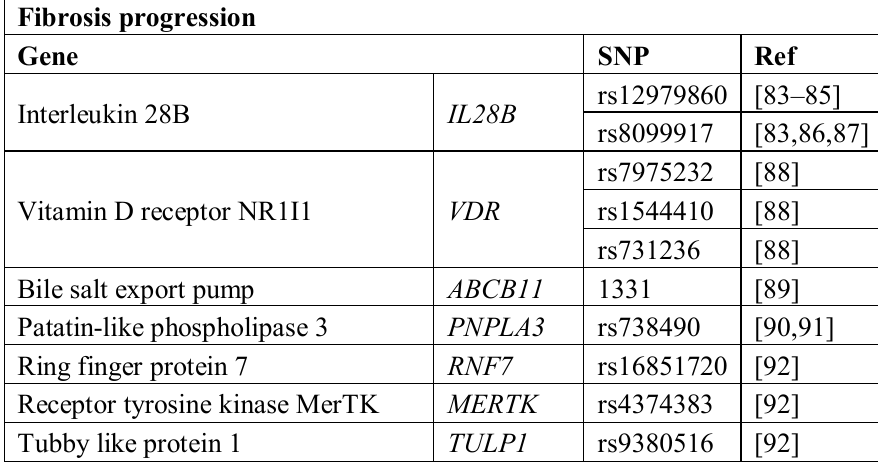
Table 2. Host genetics associated with fibrosis progression. Genetic variants were replicated in different